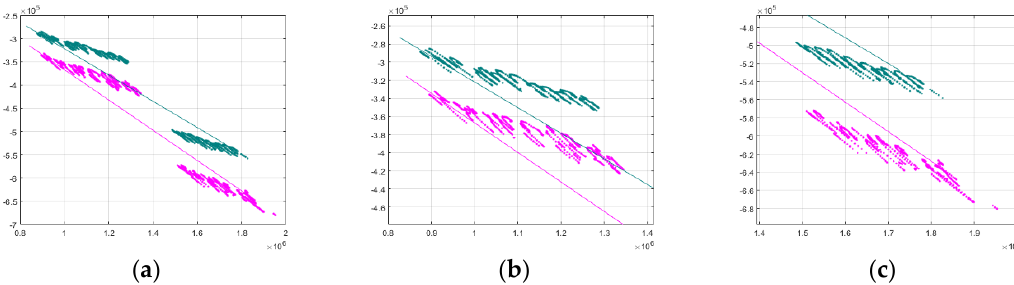
Figure 6. ( a ) shows the two most informative results for the ten representative in-air data PCA results, where ( b ) is an amplification of the results for consonants (drawn from the two results in ( a ) that the upper distribution) and ( c ) is an amplification of the results for the vowel (also drawn from the two results in ( a ) that lower distribution).